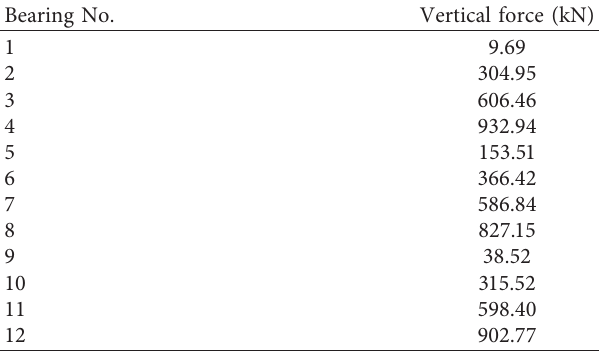
Table 6: Vertical force of bearings of Shangban Bridge (with in- fluence of the block). Bearing No.